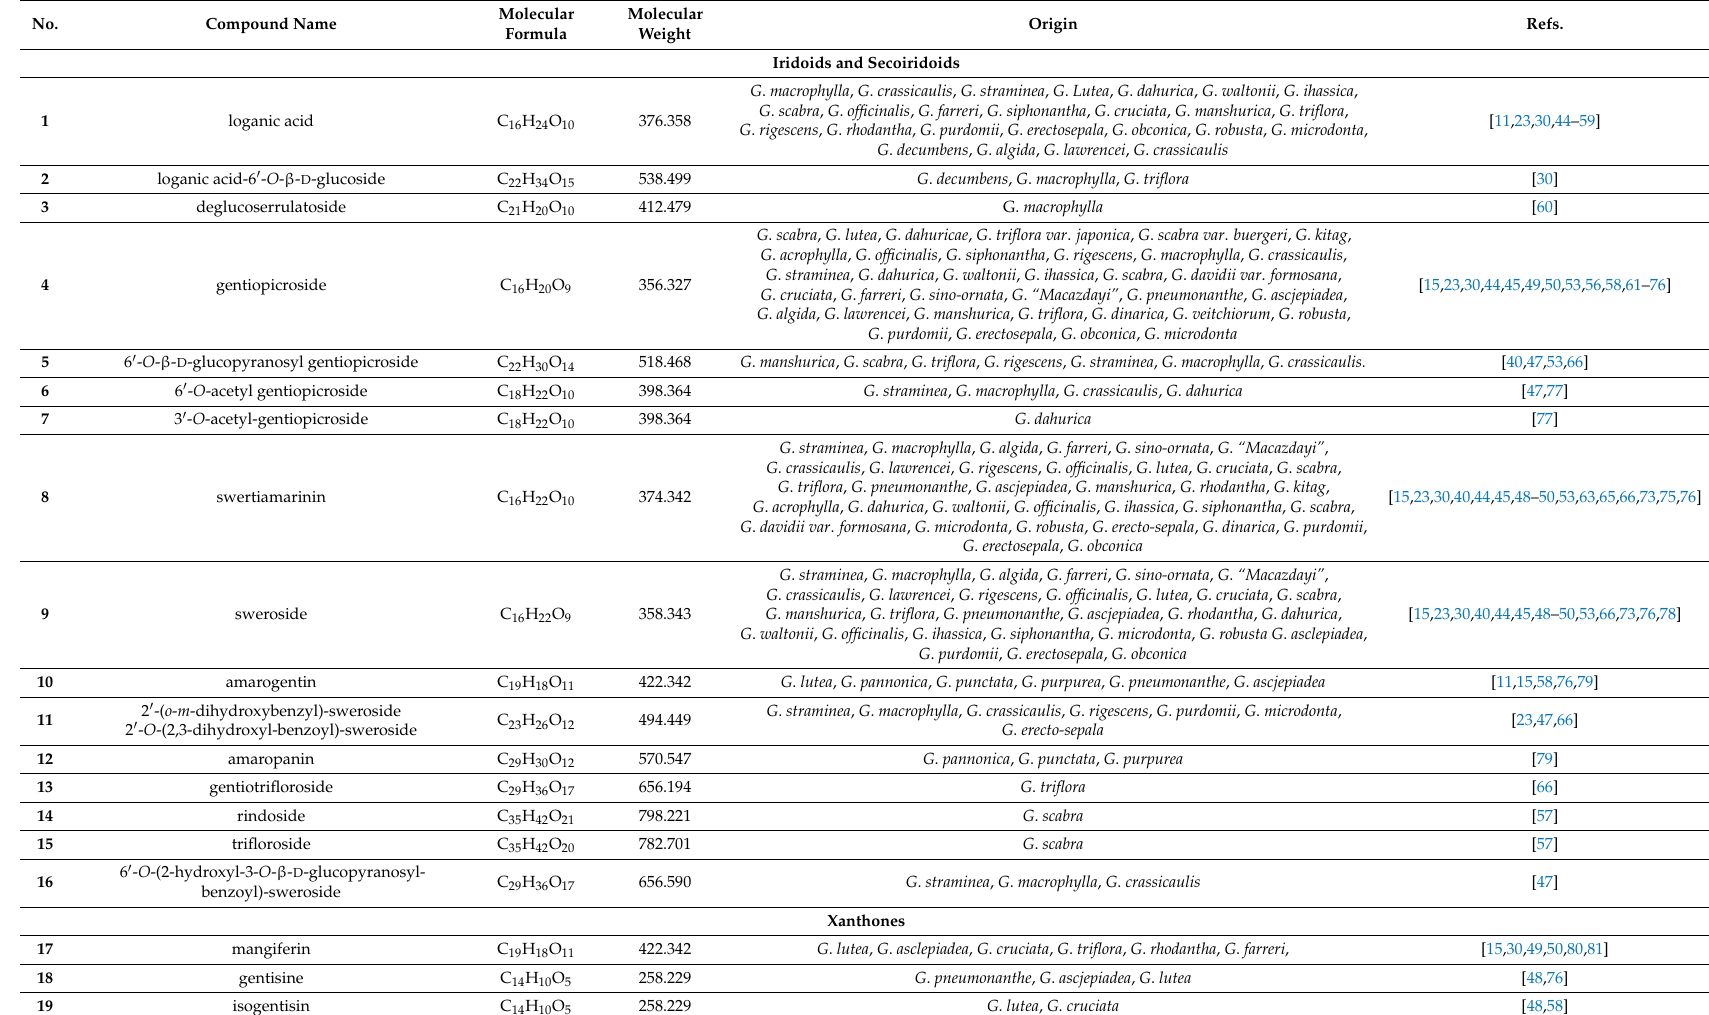
Table 1. The molecular formula, weight and origin of all